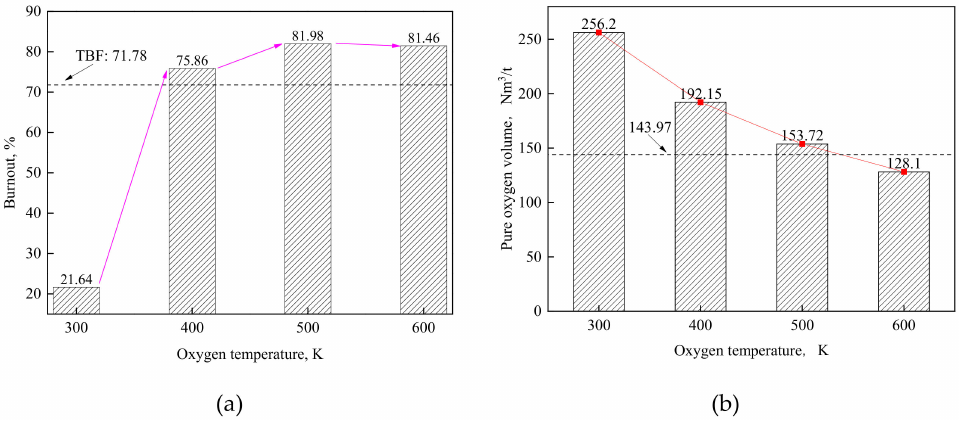
Figure 3. E ff ect of oxygen temperature: ( a ) coal burnout; ( b ) pure oxygen amount, Nm 3 / t ·